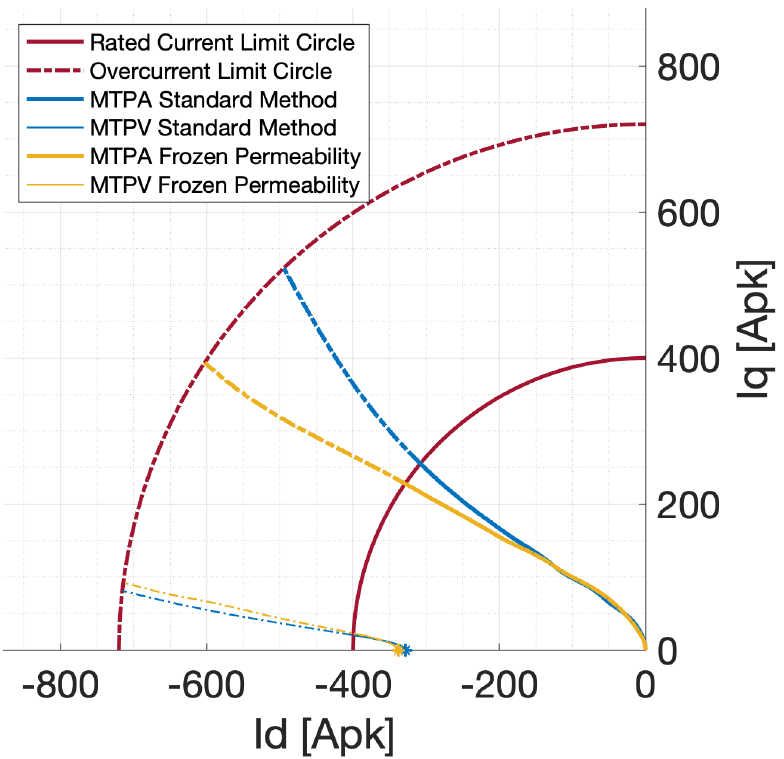
Figure 12. Comparison of MTPA and MTPV curves, obtained with Standard Method (blue) and FP (yellow).